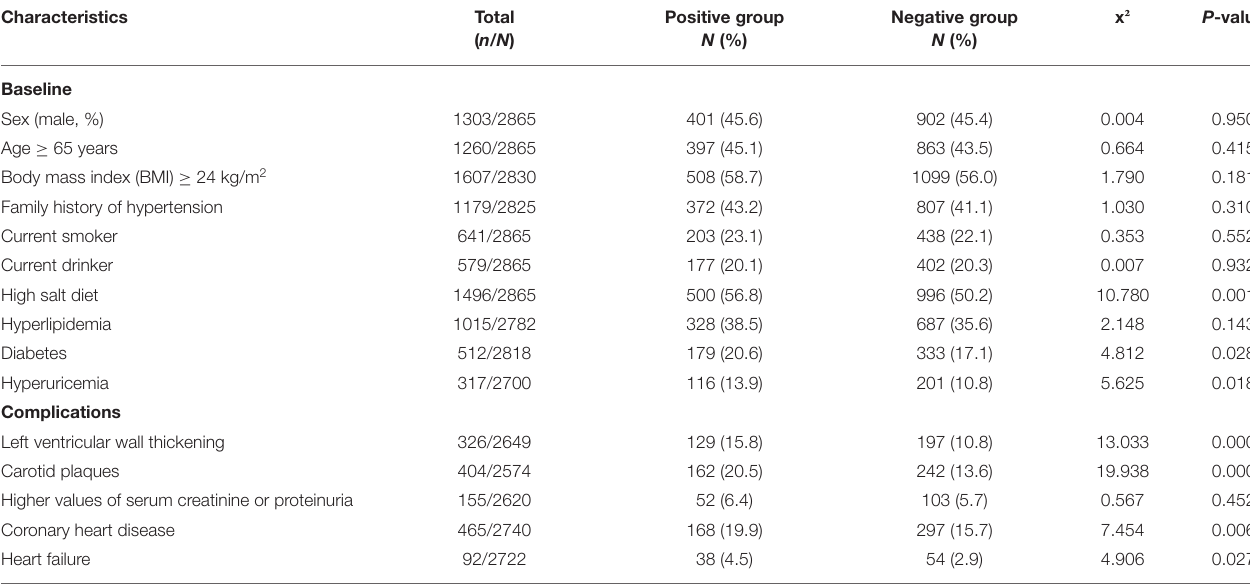
Body mass index (BMI) referred to weight in kilograms (kg) divided by height in meters squared (m2). Current smoker referred to smoking at least 1 cigarette every day. Current drinker referred to drinking alcohol at least 1 time/month in the previous 1 year. A high salt diet referred to the intake of at least 6g of salt every day. Hyperlipidemia referred to either TG ≥ 2.26